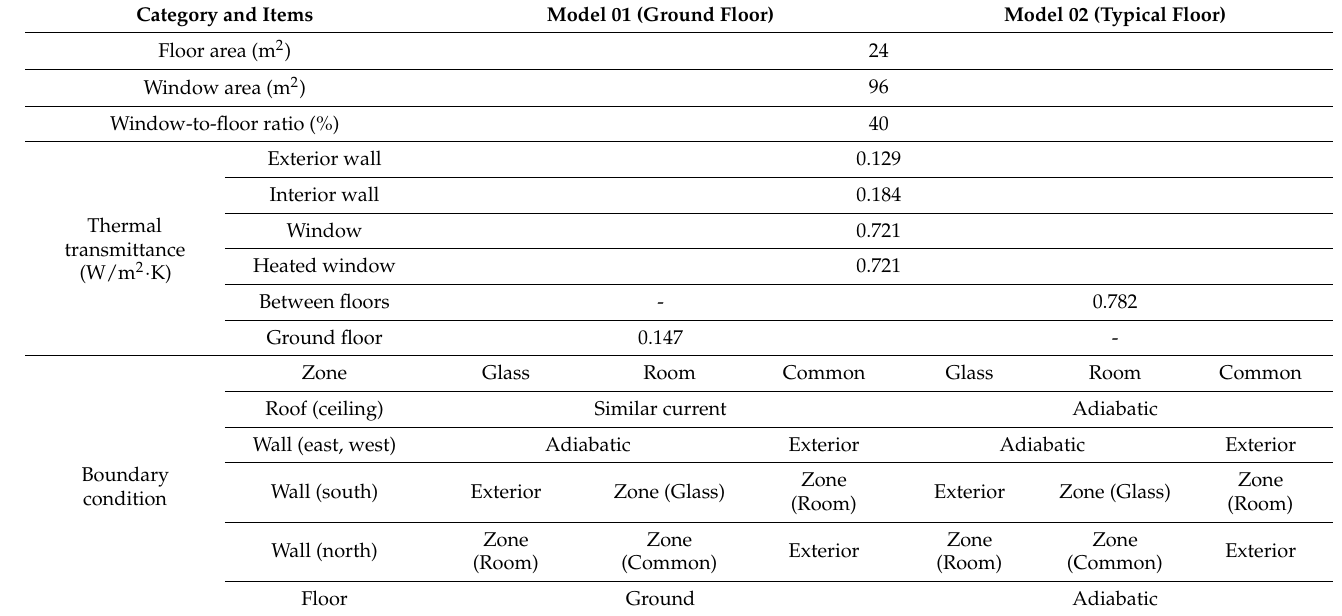
Table 2. Details of the simulation